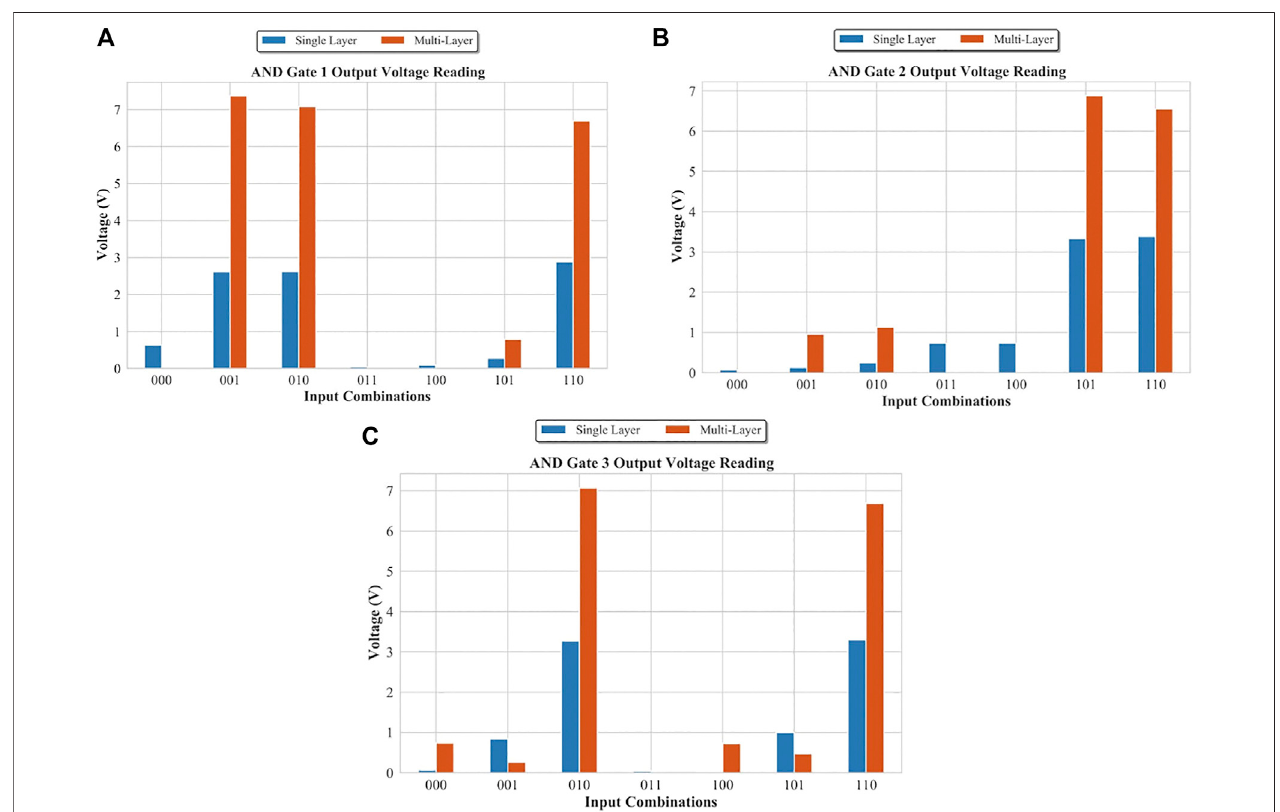
FIGURE 10 | Output voltage readings of the design of single-layer and multilayer AND logic gates for (A) gate 1, (B) gate 2, and (C) gate 3.